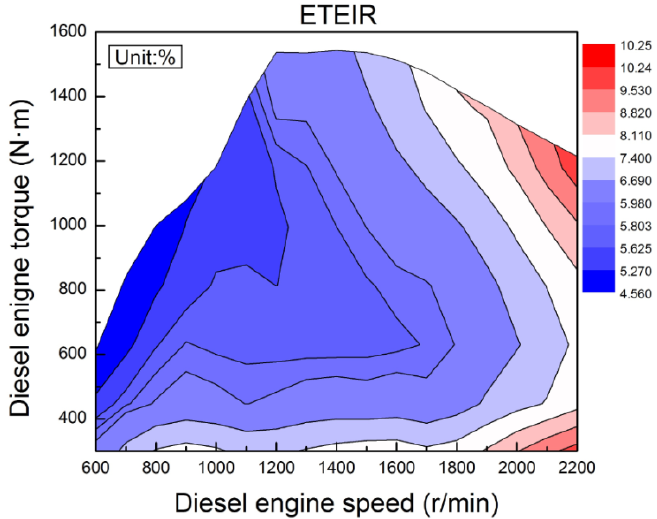
Figure 12. ETEIR under engine various operating conditions.